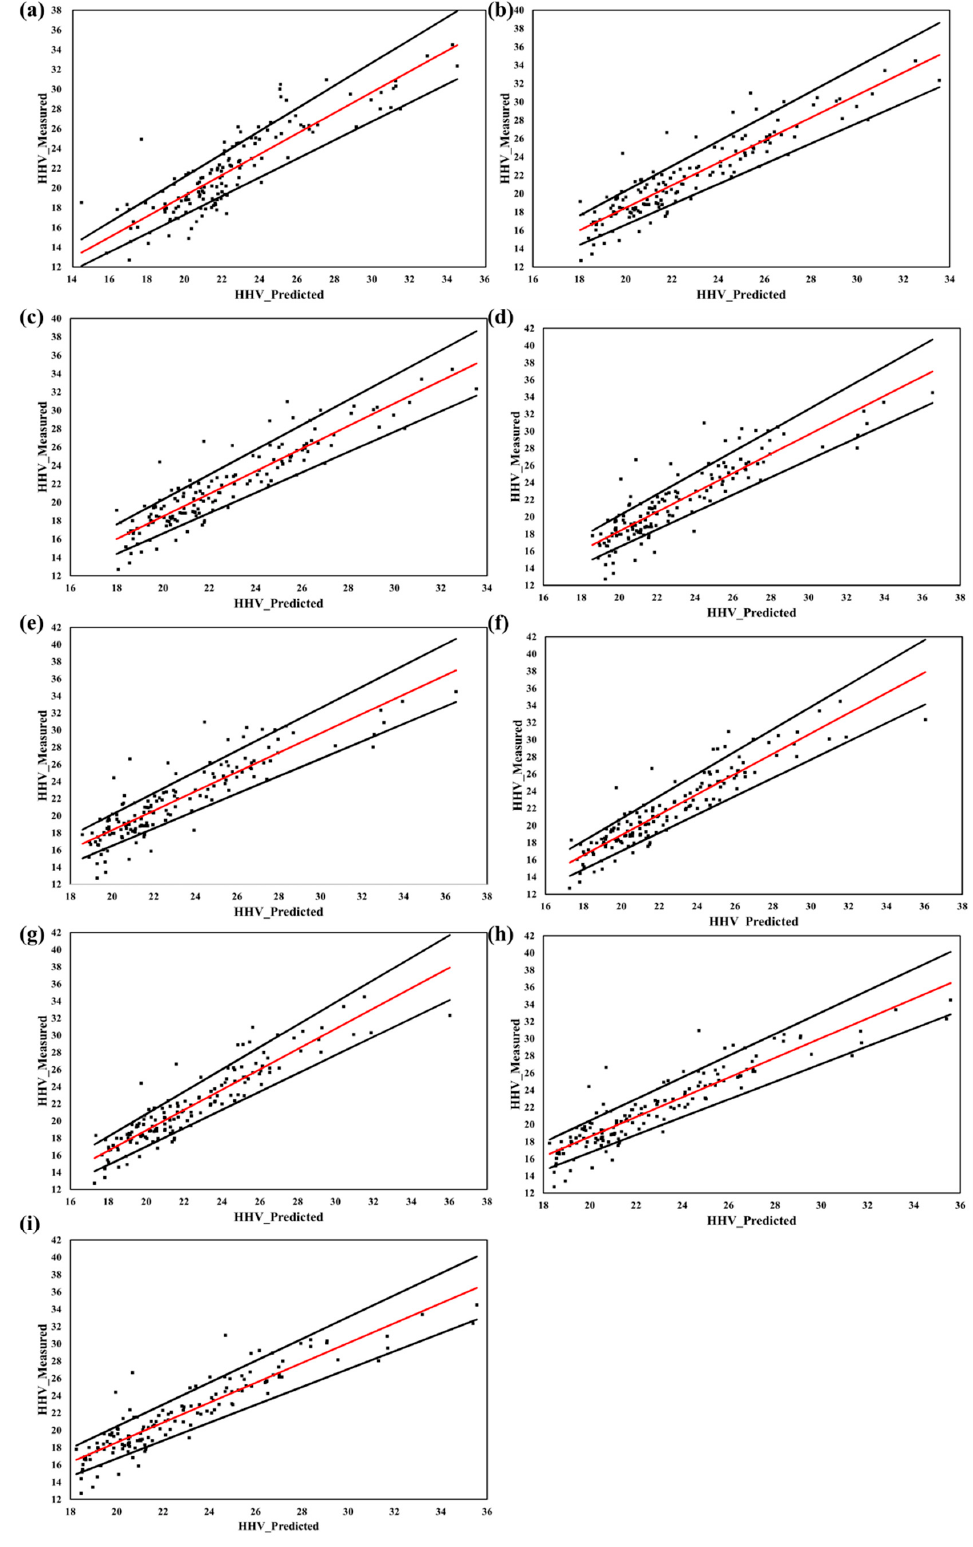
Figure 3. Scatter plots showing the comparison between predicted and experimental HHV for the ( a ) Measured, ( b ) Comb_1, ( c ) Comb_2, ( d ) Comb_3, ( e ) Comb_4, ( f ) Comb_5, ( g ) Comb_6, ( h ) Comb_7, and ( i ) Comb_8. * The black line implies ± 10% error band line.